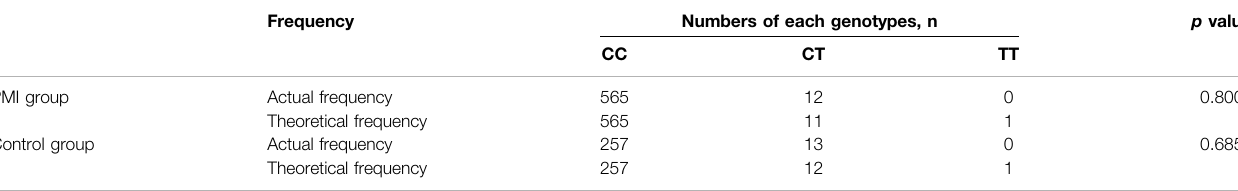
TABLE 3 | Distribution of genotypes of PCSK9 rs151193009 and Hardy – Weinberg equilibrium tests in Cohort